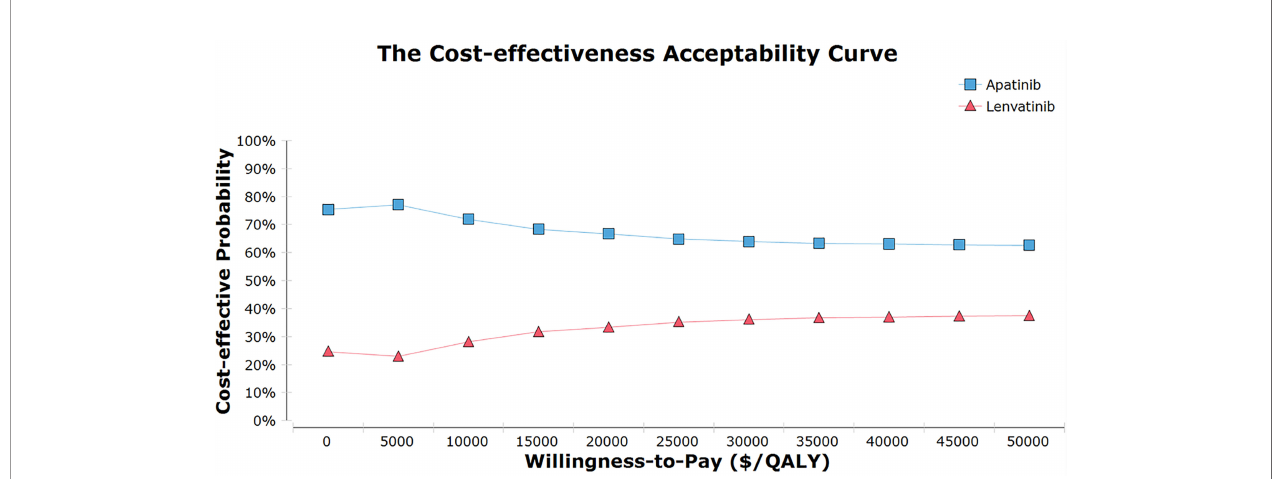
FIGURE 2 | The cost-effectiveness acceptability curves for the apatinib vs Lenvatinib. QALY, quality-adjusted life-year.